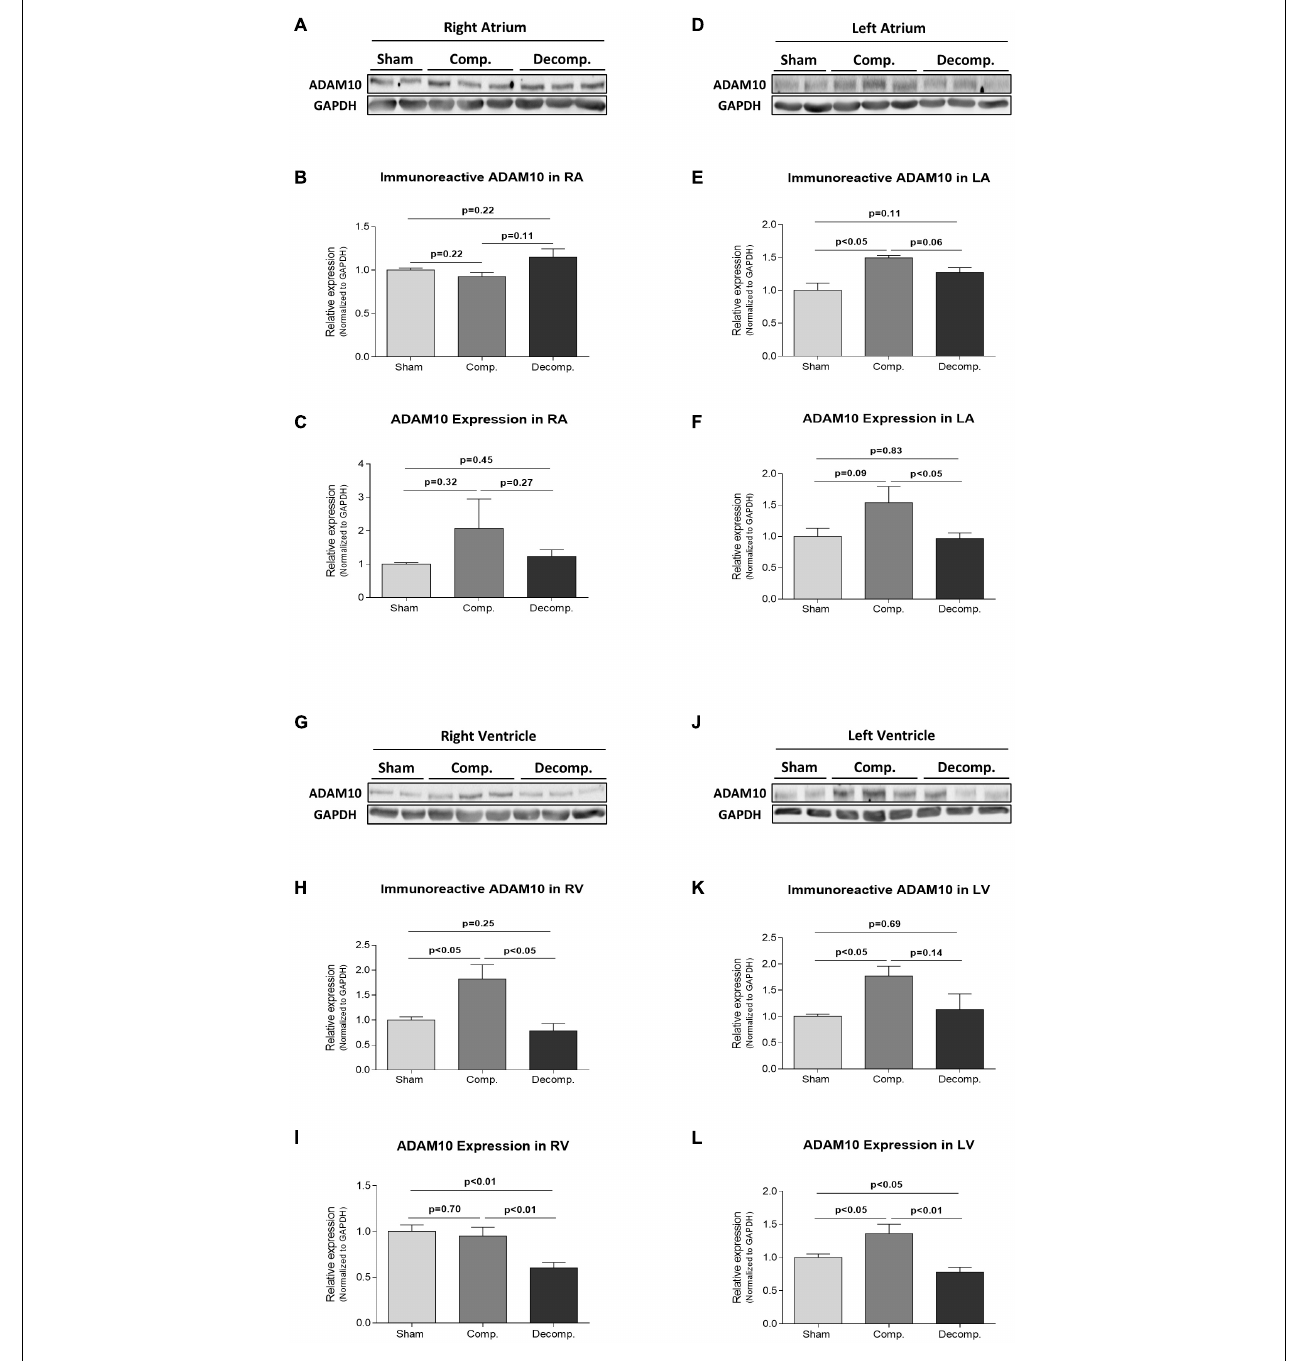
FIGURE 6 | Abundance and expression of ADAM10 in heart chambers of ACF and sham-operated rats. Representative western blot analysis of ADAM10 (A,D,G,J) and its quantification relative to GAPDH (B,E,H,K) in RA, LA, RV, and LV, respectively, of ACF and sham-operated rats. (C,F,I,L) Represent quantification of qPCR analysis of ADAM10 mRNA relative to GAPDH in the heart chambers of the different animal groups. Values are presented as means ±